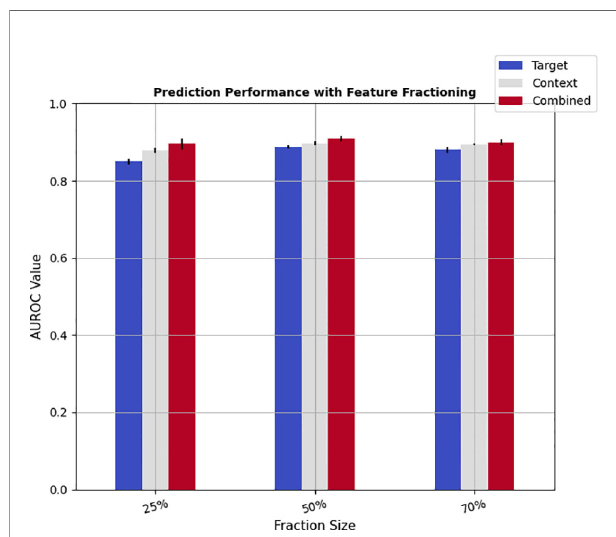
FIGURE 4 | Effect of training size on the prediction power of the hybrid feature sets.